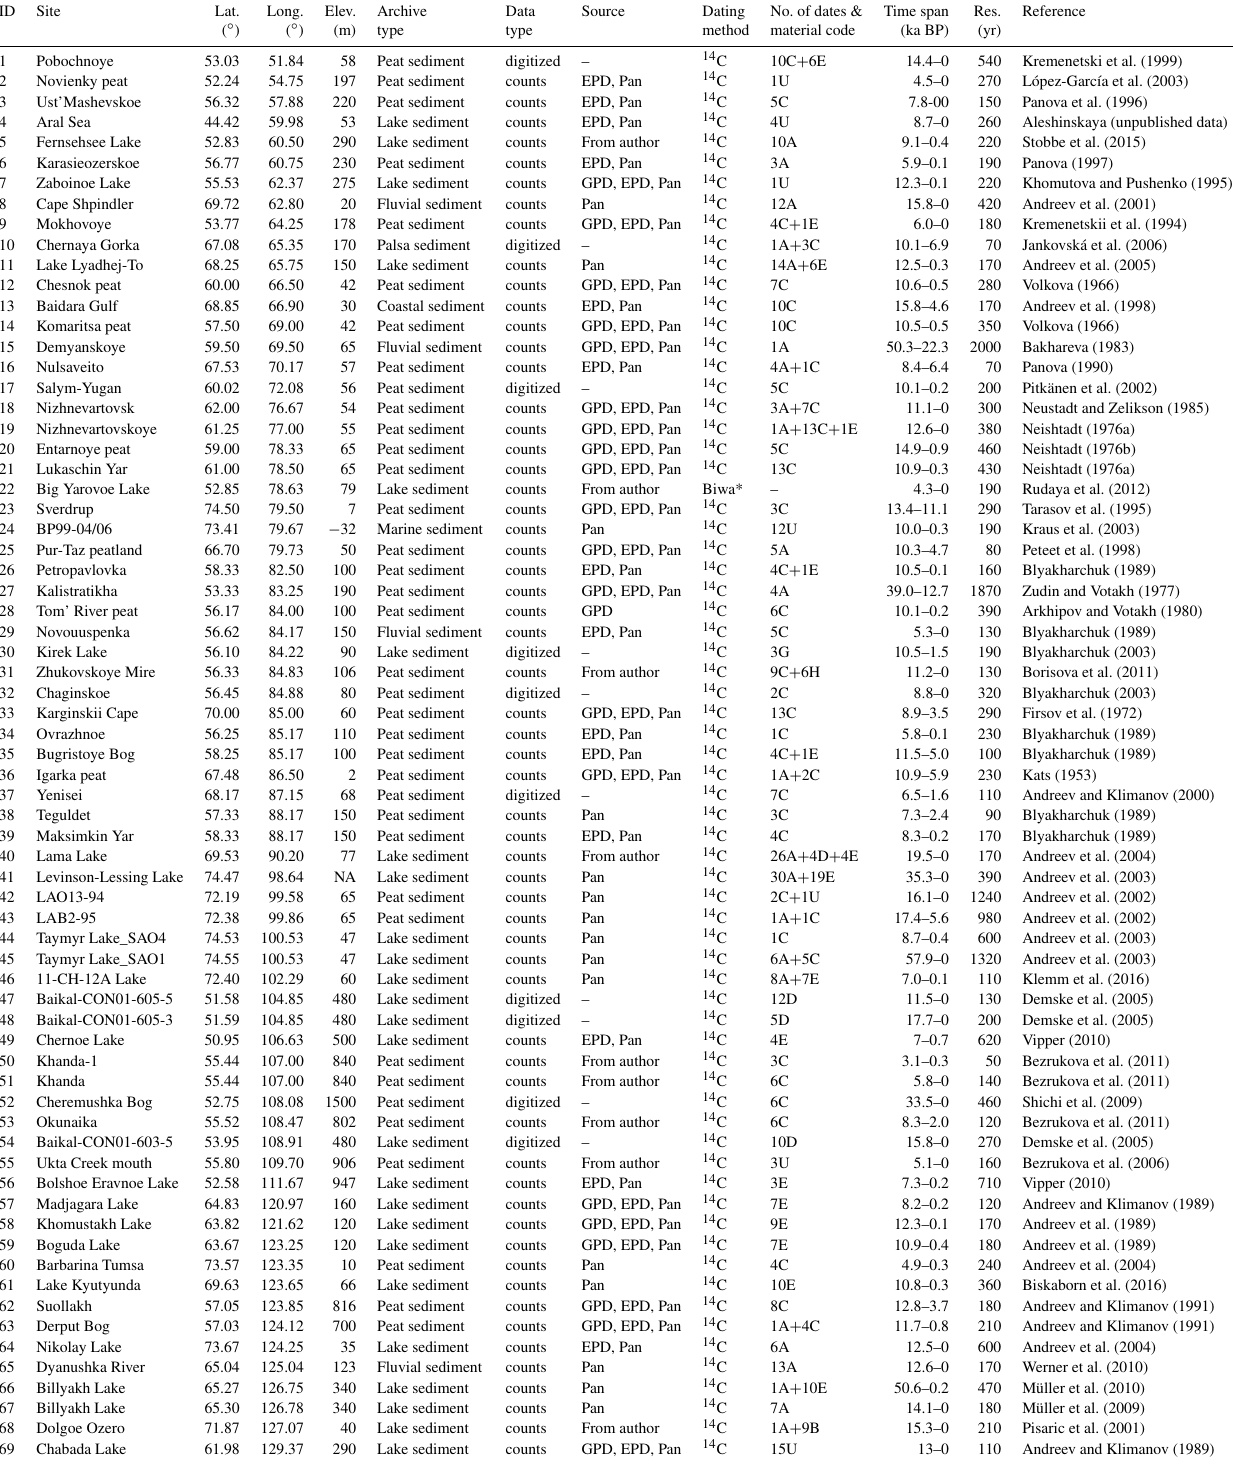
Table A1. Details of the fossil pollen records in the Siberian pollen dataset. NA – not